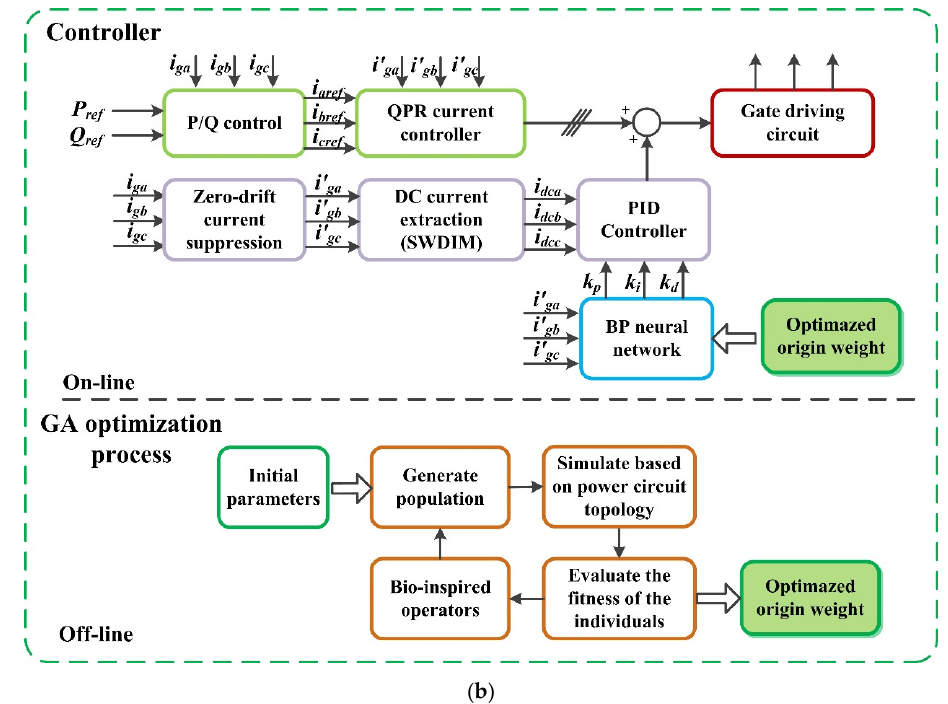
Figure 2. Block diagram of the proposed direct current (DC) suppression scheme. ( a ) Power circuit topology of the inductive-capacitive-inductive (LCL) filter. ( b ) Block diagram of the controller. In Figure 2, v a , v b , and v c are the inverter-side output voltages. i ga , i gb, and i gc are the grid currents of each phase. i aref , i bref , and i cref are the reference currents. L inva , L invb , and L invc are the inverter-side inductance. L ga , L gb , and L gc are the grid-side inductance. e ga , e gb , and e gc are the three-phase grid voltages. u dc is the DC bus voltage. The sliding window double-integration method (SWDIM) was used to extract the grid current.